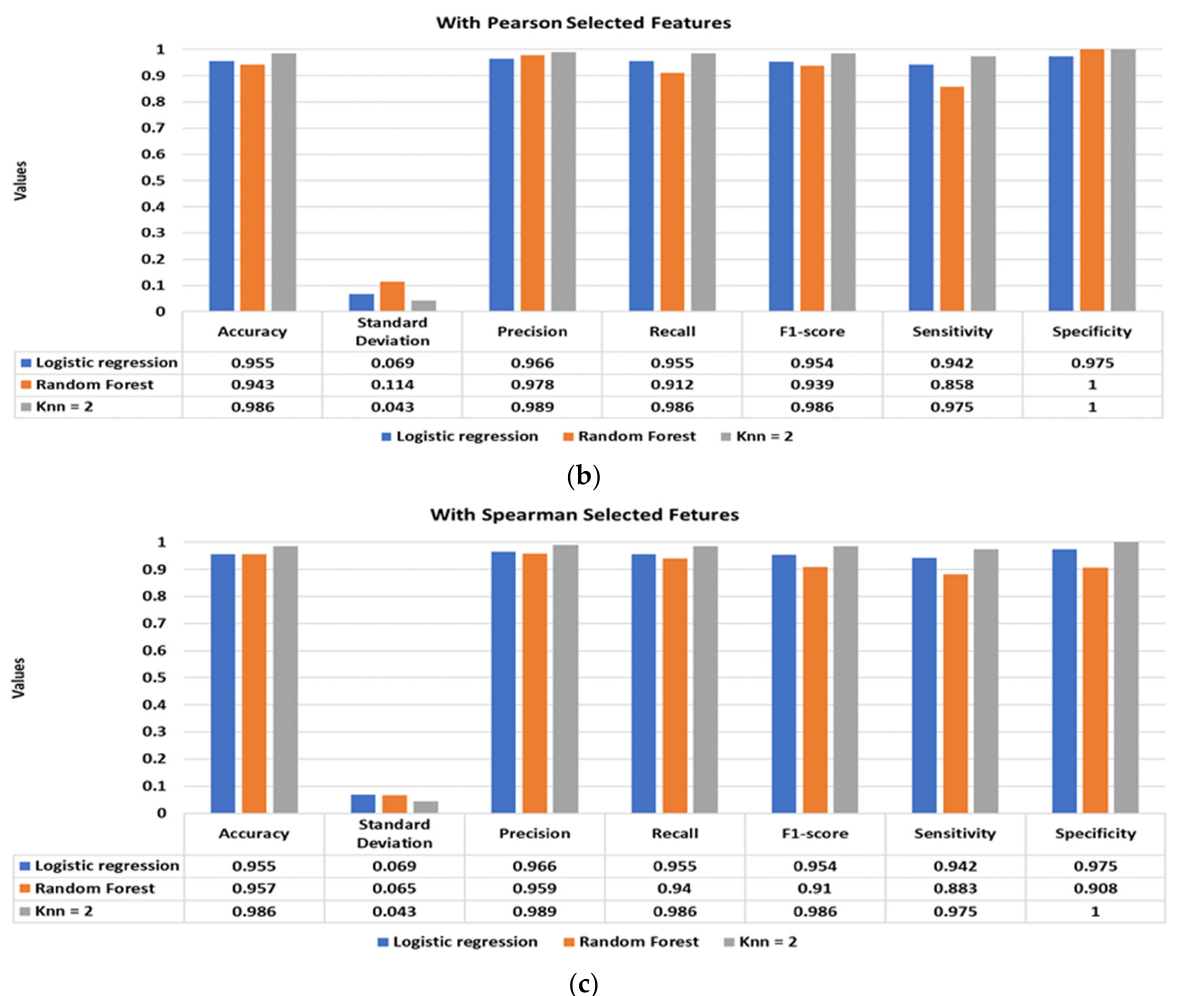
Figure 5. Shortlisted features-based stress versus baseline classification using logistic regression, random forest, and K-nearest neighbours classifiers. ( a ) Using Pearson shortlisted features, ( b ) using Kendall shortlisted features, and ( c ) using Spearman shortlisted features.